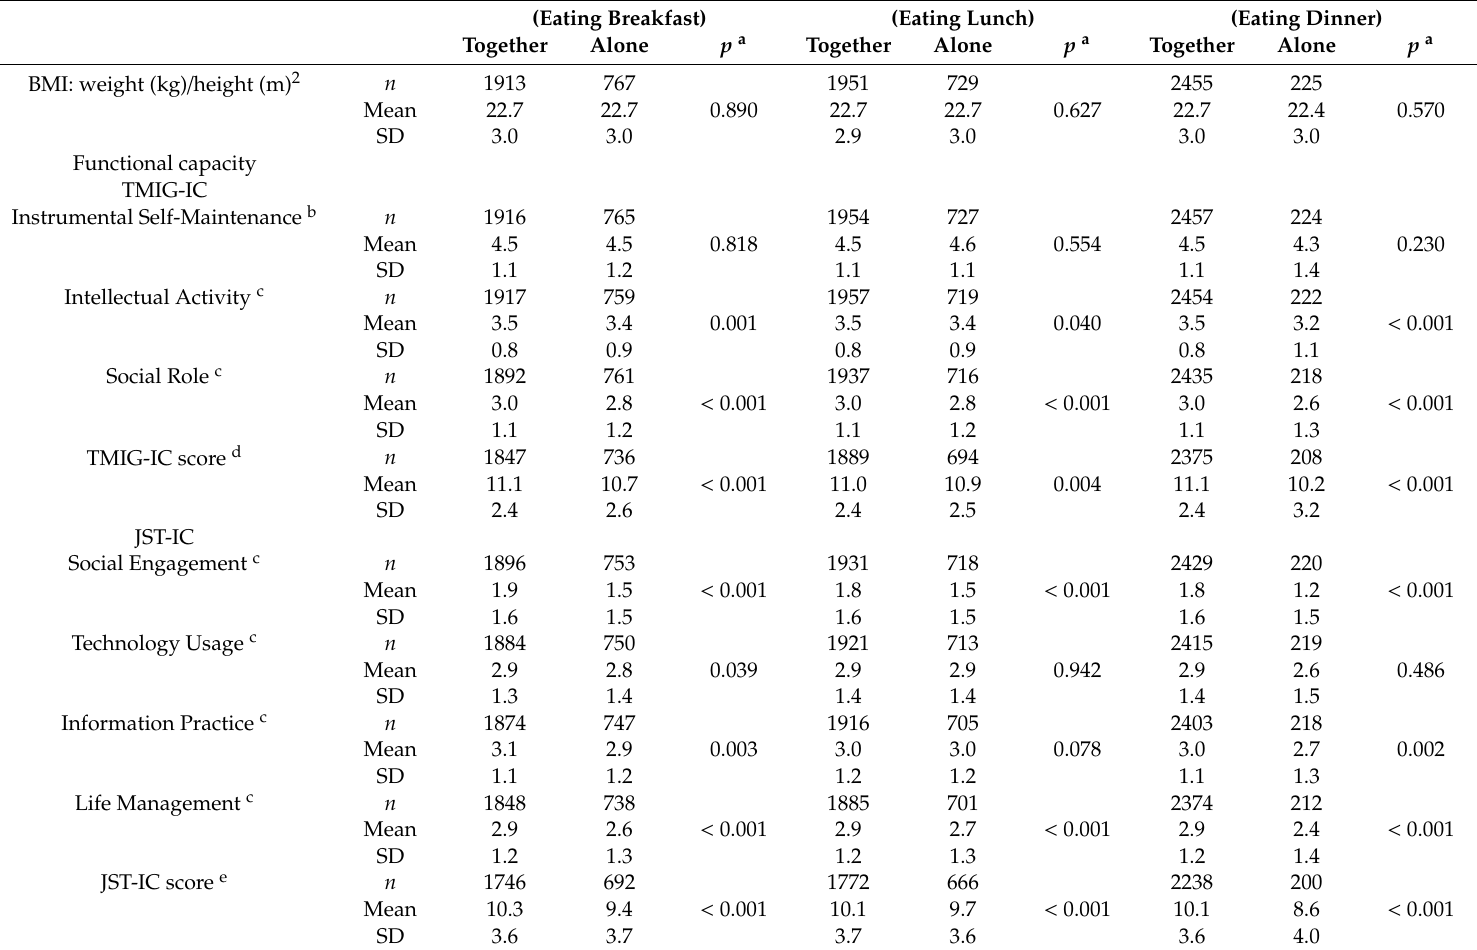
Table 3. Association of eating alone at each meal with BMI and scores of functional capacity ( n =